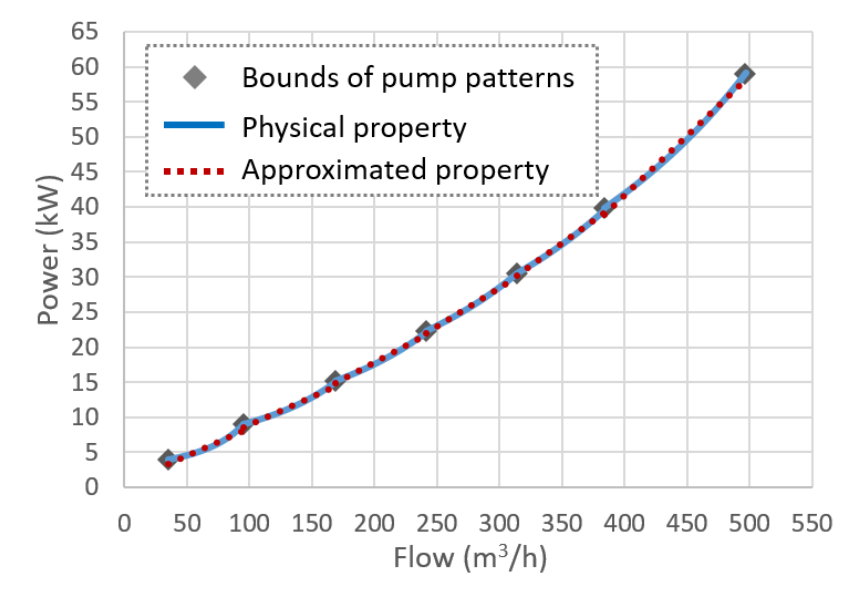
Figure 5. Result of the approximated properties of water